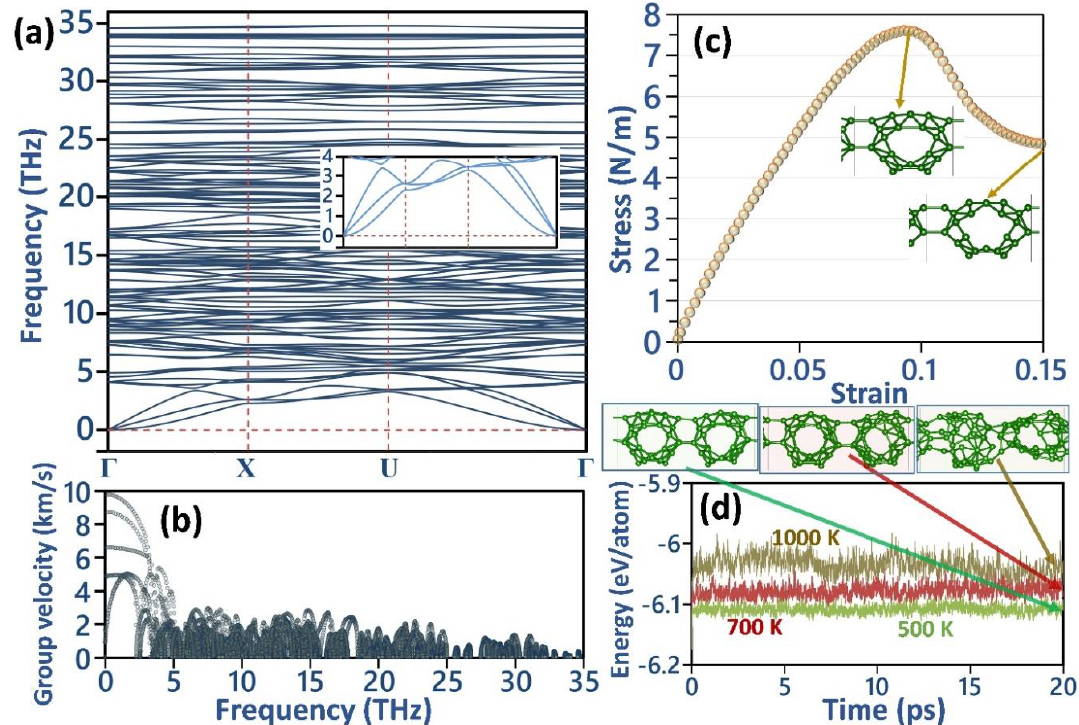
Figure 2. ( a ) Phonon dispersion and ( b ) group velocity of the predicted single-layer B 40 network. ( c ) Uniaxial stress – strain at the ground state along with side views of the deformed structures. ( d ) The AIMD results for the per atom total energy of the B 40 nanosheet during the simulations at temperatures of 500, 700, and 1000 K. The insets in panel ( d ) show the side views for the final atomic configurations after 20 ps of AIMD simulations.